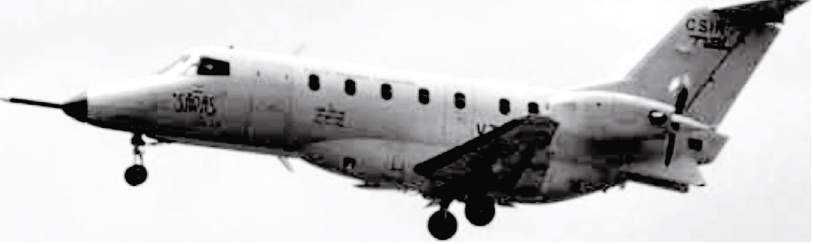
Figure 2: The SARAS 14-seater aircraft